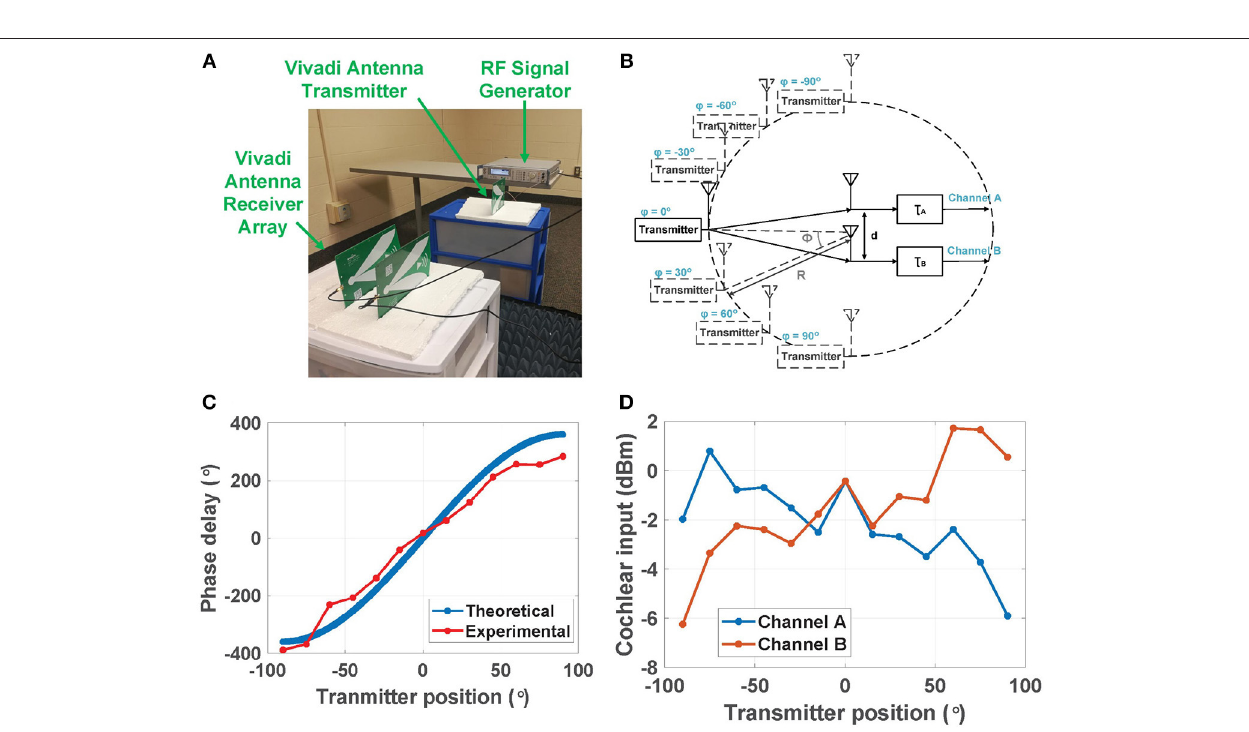
FIGURE 12 | (A) Experimental setup of a two-channel RF scene analysis system used for over-the-air localization experiments at 3.0 GHz. (B) Positions of the transmitter (moving around the circumference) and the two receive antennas (kept fixed). (C) Theoretical and experimental phase delay 1ψ (i.e., ITD) between the two channels at different transmitter positions; and (D) experimental input power levels for the two channels at different transmitter